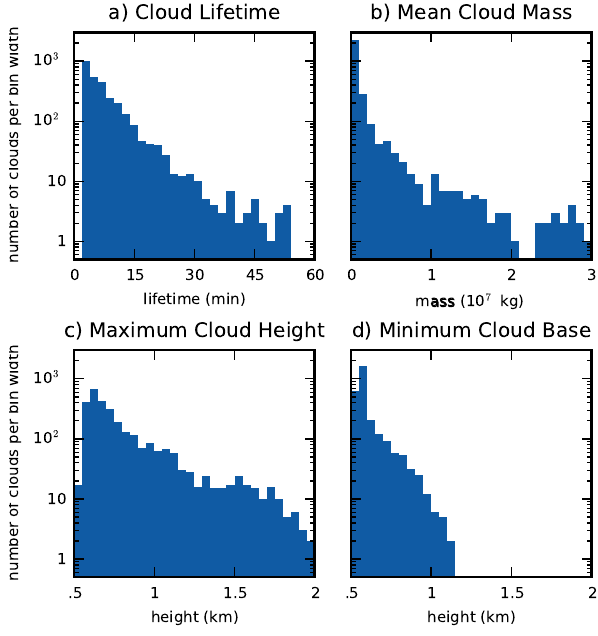
Fig. 6. Histograms of (a) cloud lifetime in minutes (with a 2min bin width), (b) mean mass of the cloud condensed region over the cloud lifetime (10 6 kg bin width), (c) maximum height reached by the cloud top (50m bin width), and (d) minimum height of the cloud base (50m bin width) for tracked clouds with complete life histo- ries.